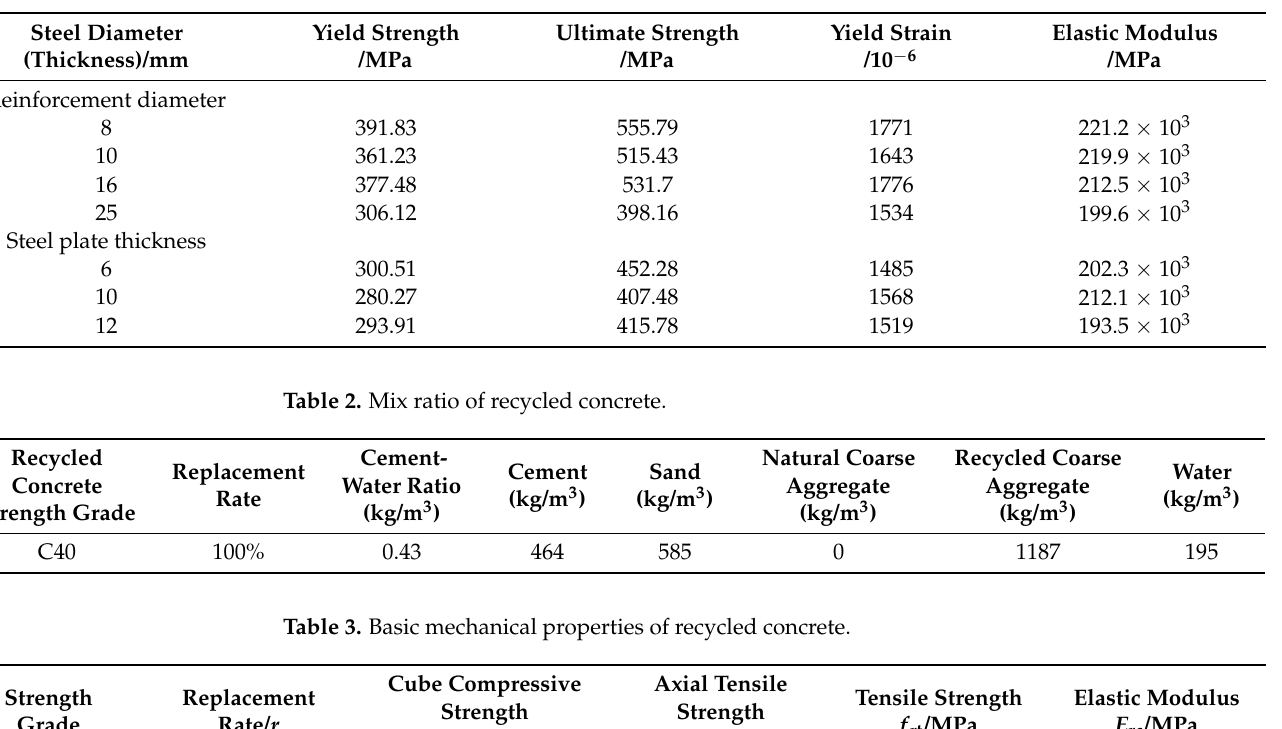
Table 1. Mechanical performance indexes of steel.